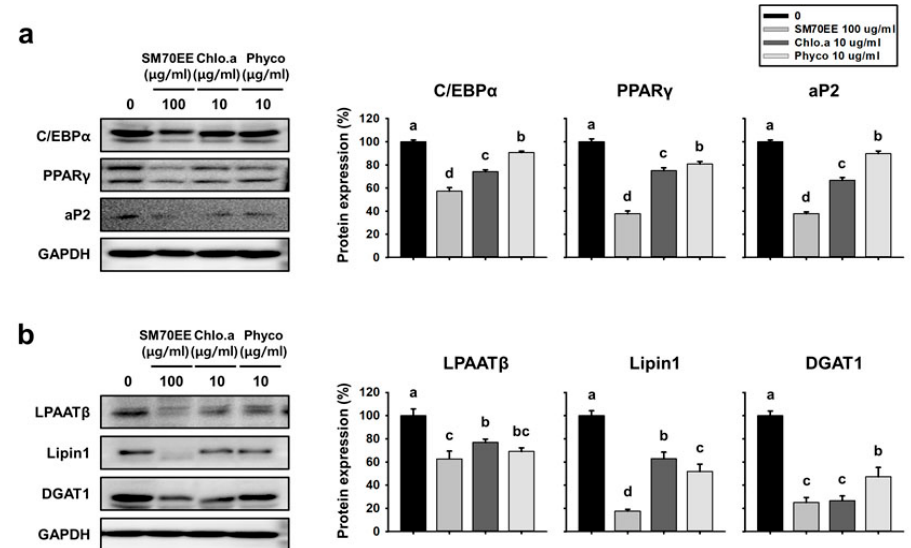
Figure 3. SM70EE, chlorophyll a, and C-phycocyanin reduce the expression of adipogenic and lipogenic proteins in C3H10T1/2 cells. ( a ) Western blots of adipogenic protein (C/EBP α , PPAR γ , and aP2) expression after differentiation for 8 days. Quantification graphs for C/EBP α , PPAR γ , and aP2 expression. ( b ) Western blots of lipogenic protein (SREBP1, LPAAT β , Lipin1, and DGAT1)